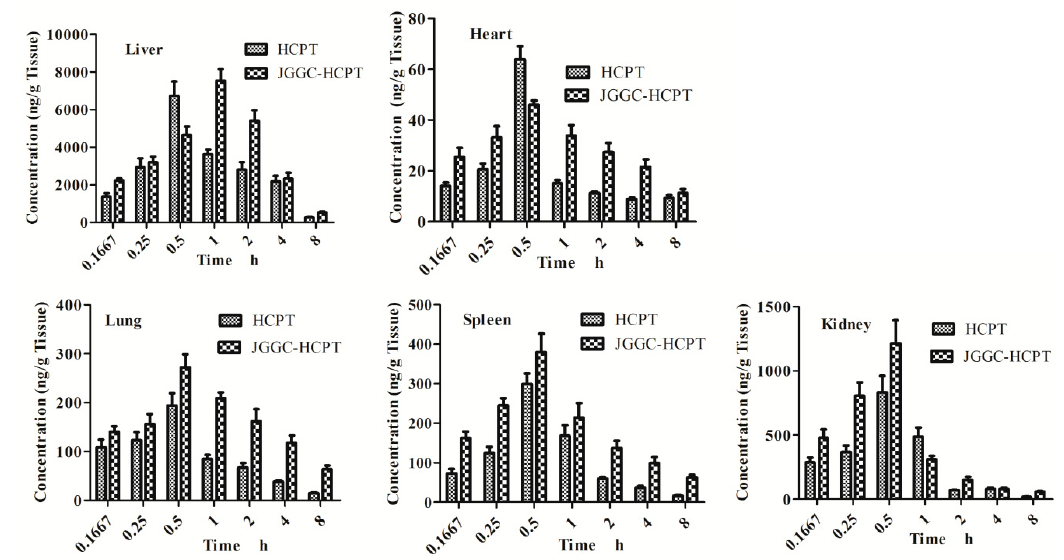
Figure 2. Effect of pretreatment with Platycodonis Radix-Glycyrrhizae Radix ET Rhizoma extract on primary tissue distributions of HCPT in C57BL/6J mice. Data are shown as means ± SD, n = 6.